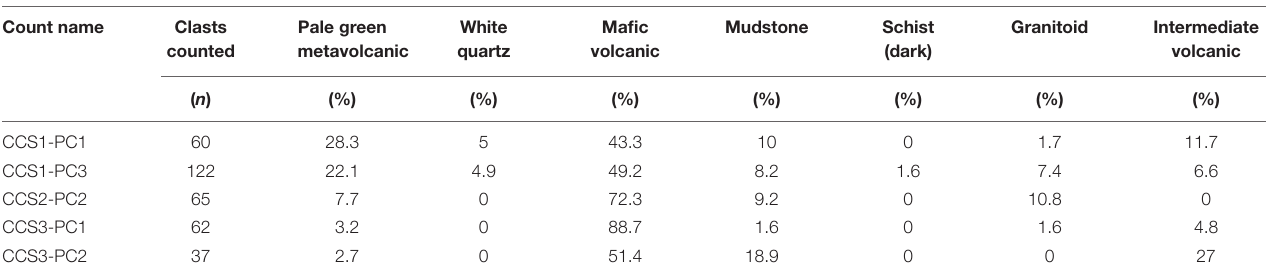
TABLE 4 | Recalculated modal clast composition